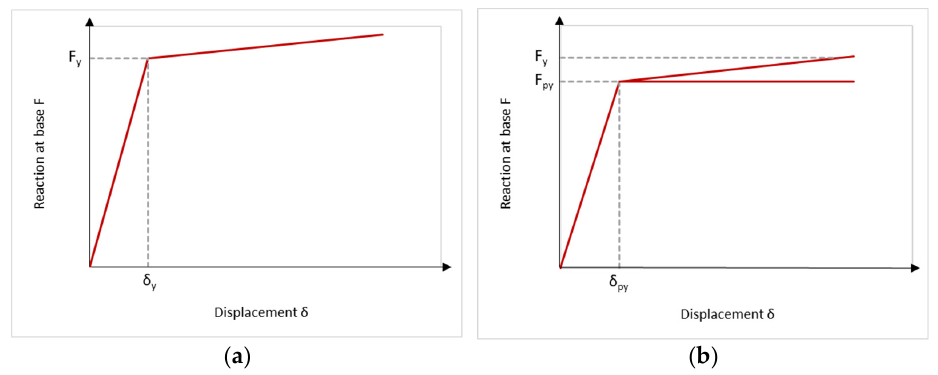
Figure 7. Definition of ( a ) yield F y and ( b ) pseudo-yield F py .